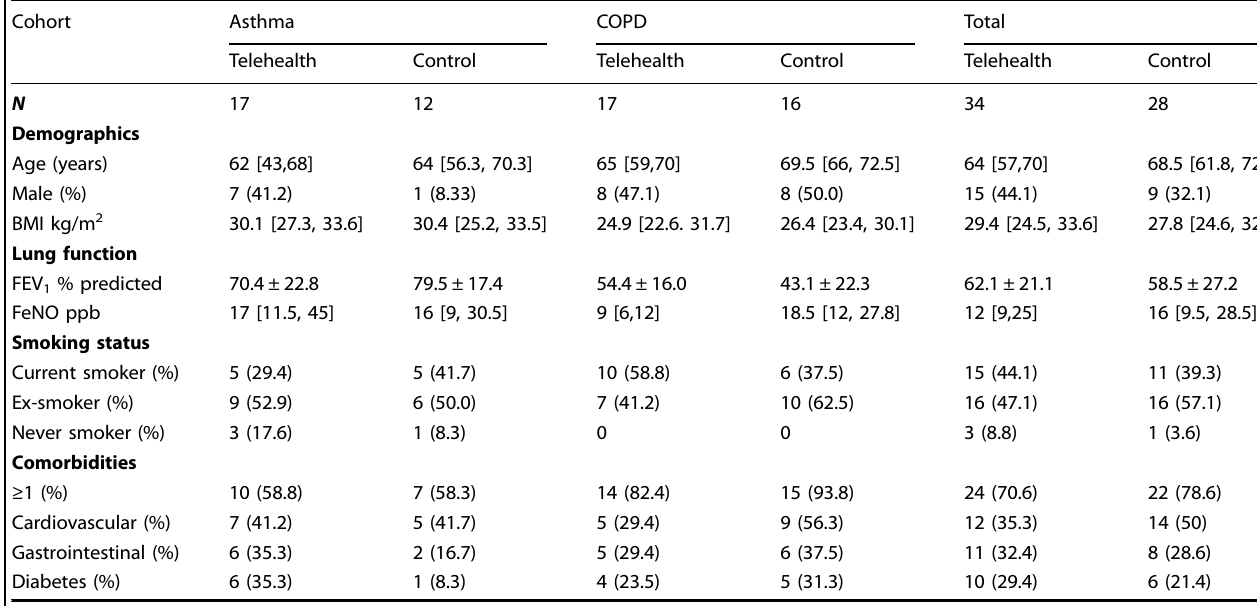
Table 1. Participant characteristics.